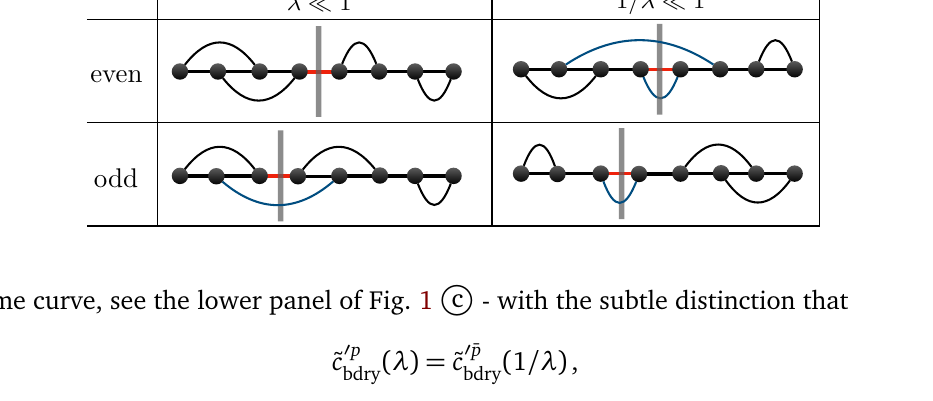
Table 1: Simplified valence bond picture for strong (weak) impurity bonds λ (cid:28) 1 (1 /λ (cid:28) 1) for both even and odd scenarios. The bonds separating the regions of the bipartition are illustrated by grey lines, and inter- (intra-) subsystems valence bonds are depicted by black (dark blue) curved lines. Each blue line corresponds to an entanglement entropy of ln2.  1 1 / ⌧ ⌧